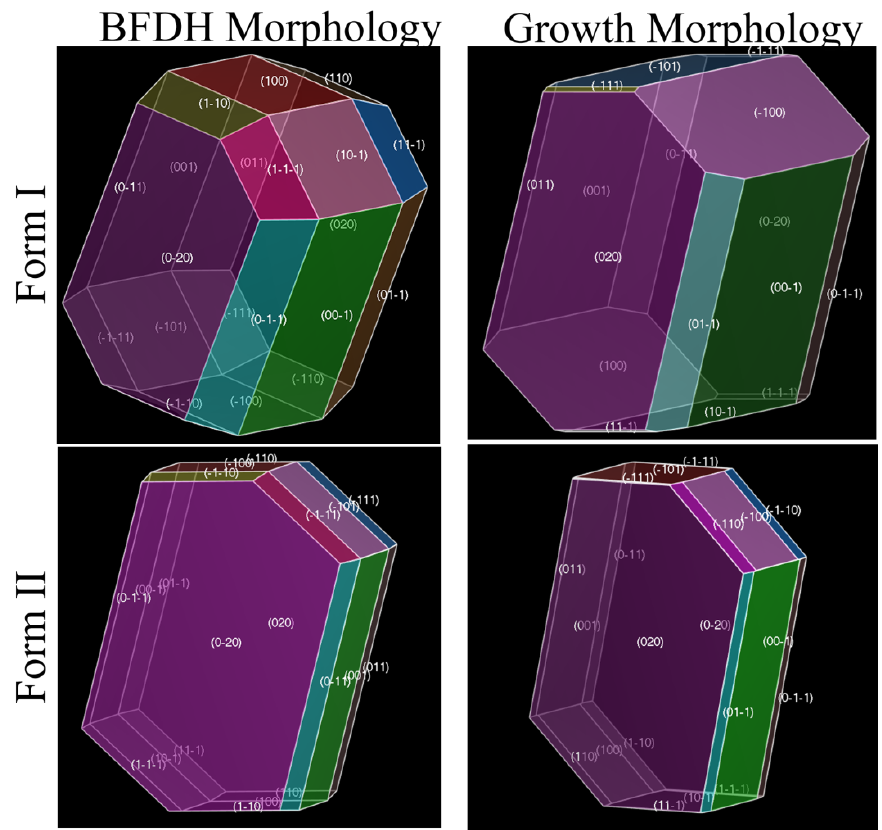
Figure 7. The BFDH and growth morphology of Form I and II. The morphologically important faces are evidenced together with their Miller indices.